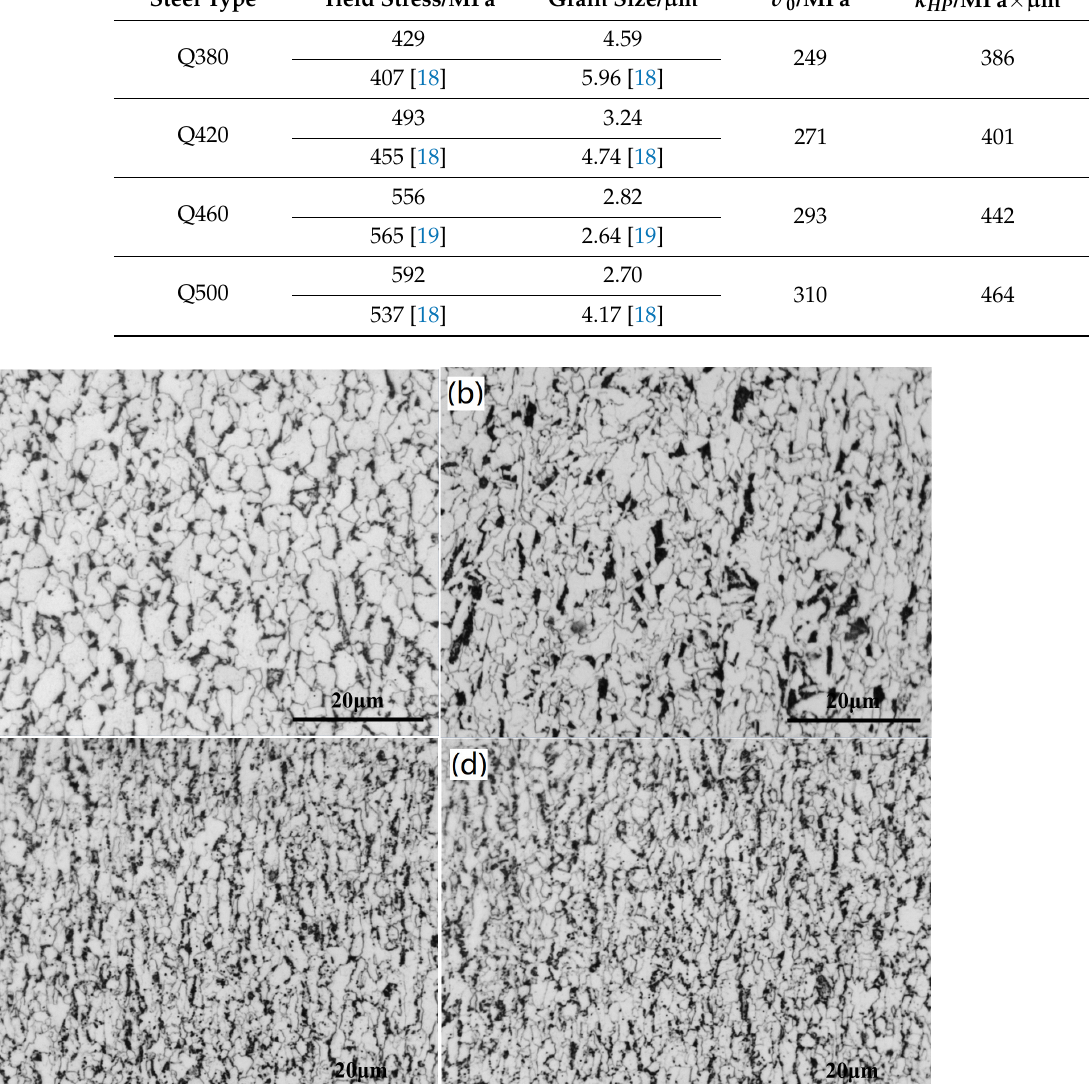
Table 2. Calculated parameters of Hall–Petch relationship for different steels. Steel Type